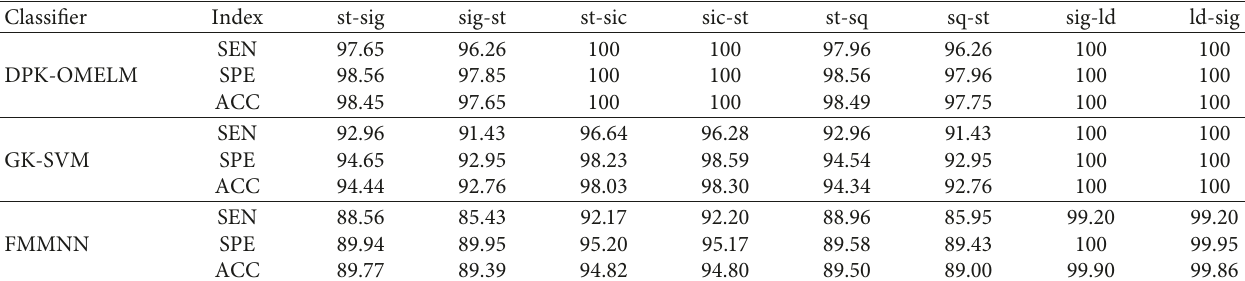
Table 7: SEN, SPE, and ACC of each posture transition under DPK-OMELM, GK-SVM, and FMMNN